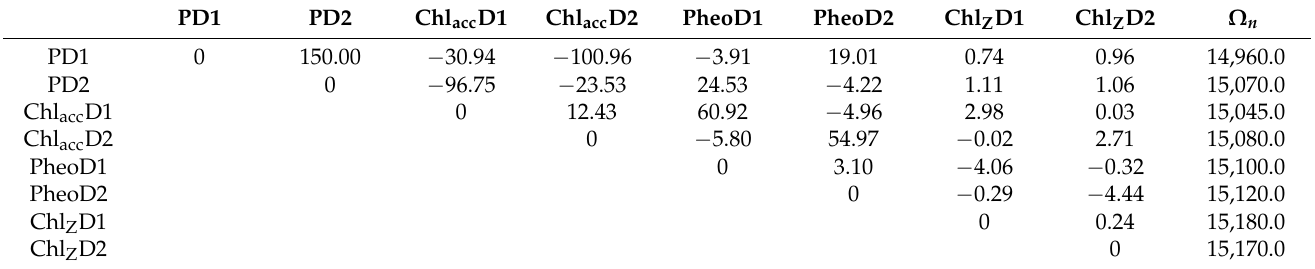
Figure 2. Optical properties of monomeric Chl, the main pigment of Photosystem II reaction center: the spectral density (red) of Chl and the simulated absorption (blue) and fluorescence spectra (magenta) of Chl ( A ); the mutual orientation of Photosystem II reaction center cofactors ( B ) is a key factor in the exciton theory (a scheme ( D ) of the energy levels of PSIIRC) that was applied to simulate absorption, circular and linear dichroism, and steady-state fluorescence spectra. These spectra were used as the target functions ( C ). Table 1. Material Hamiltonian of the PSIIRC exciton model used for simulation of target functions.